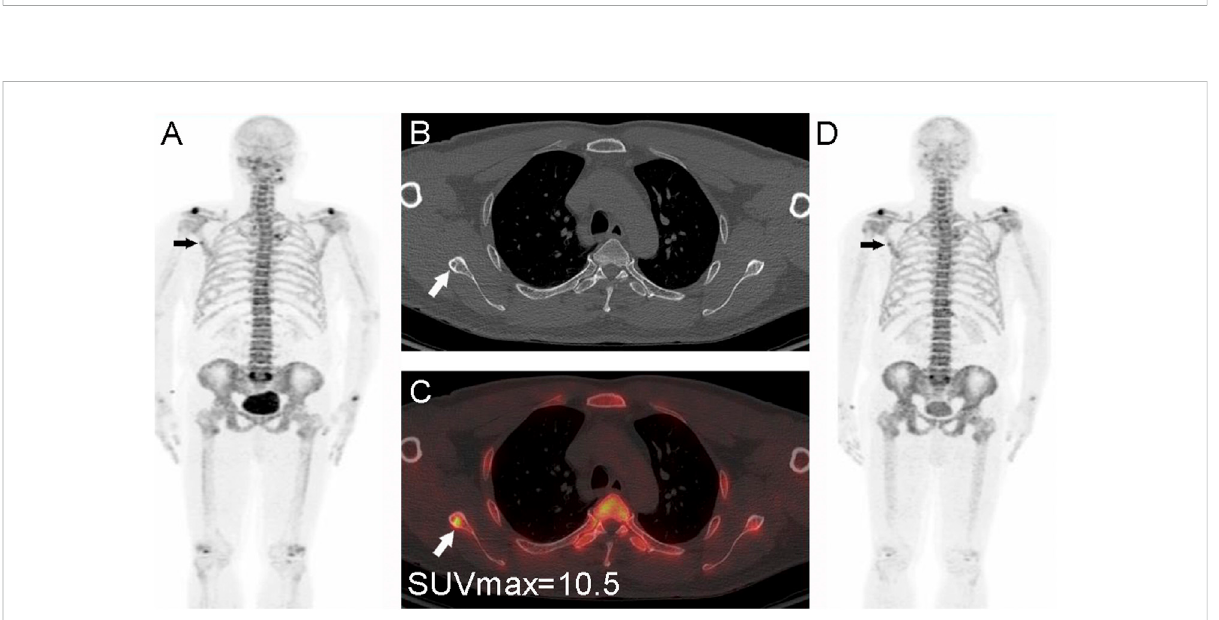
FIGURE 6 Nasopharyngeal carcinoma (T2N2M0) in a 56-year-old male patient. The whole-body PET MIP image (A) , arrow shows a focal mild abnormal 18 F-NaF uptake in the right scapula, CT (B) , small arrow shows a small sclerotic border, PET/CT image (C) shows a localized 18 F-NaF uptake, and measurement of the lesion with SUVmax = 10.5 < 12.5. The lesion was fi rst considered benign based on the CT fi ndings and the degree of metabolism. A follow-up PET/CT (D) , arrow at 1 year showed no metabolic changes and thus con fi rming the benign